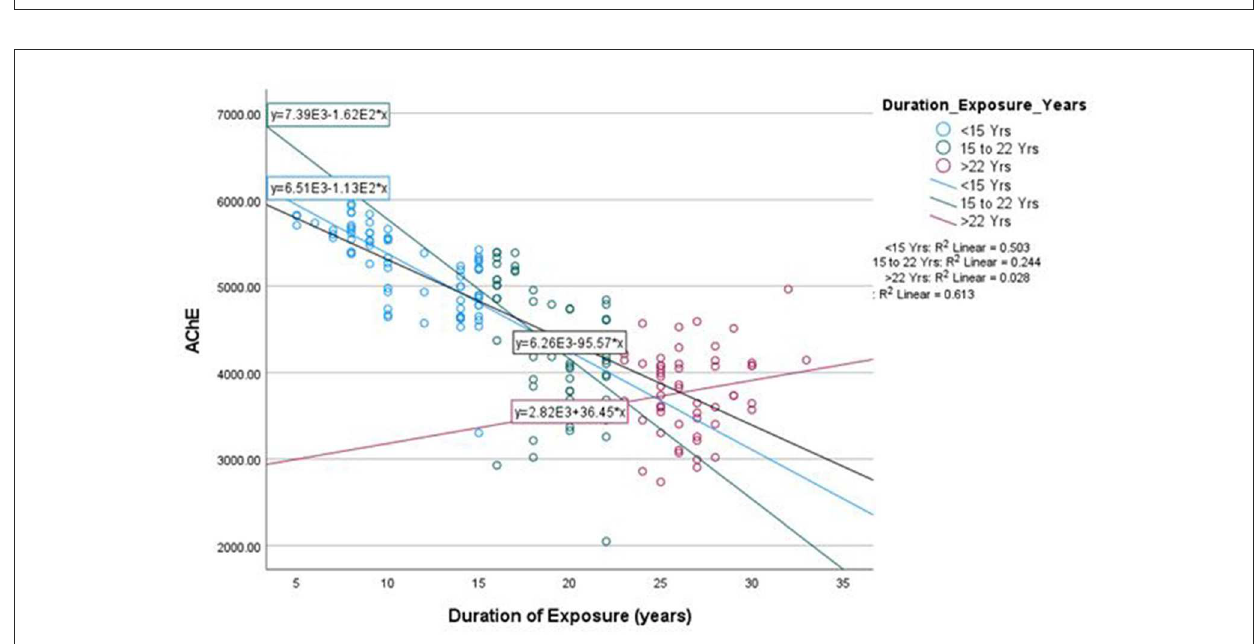
FIGURE4 Linear regression between duration of exposure and AChE activity among exposed farm-workers ( n = 180).